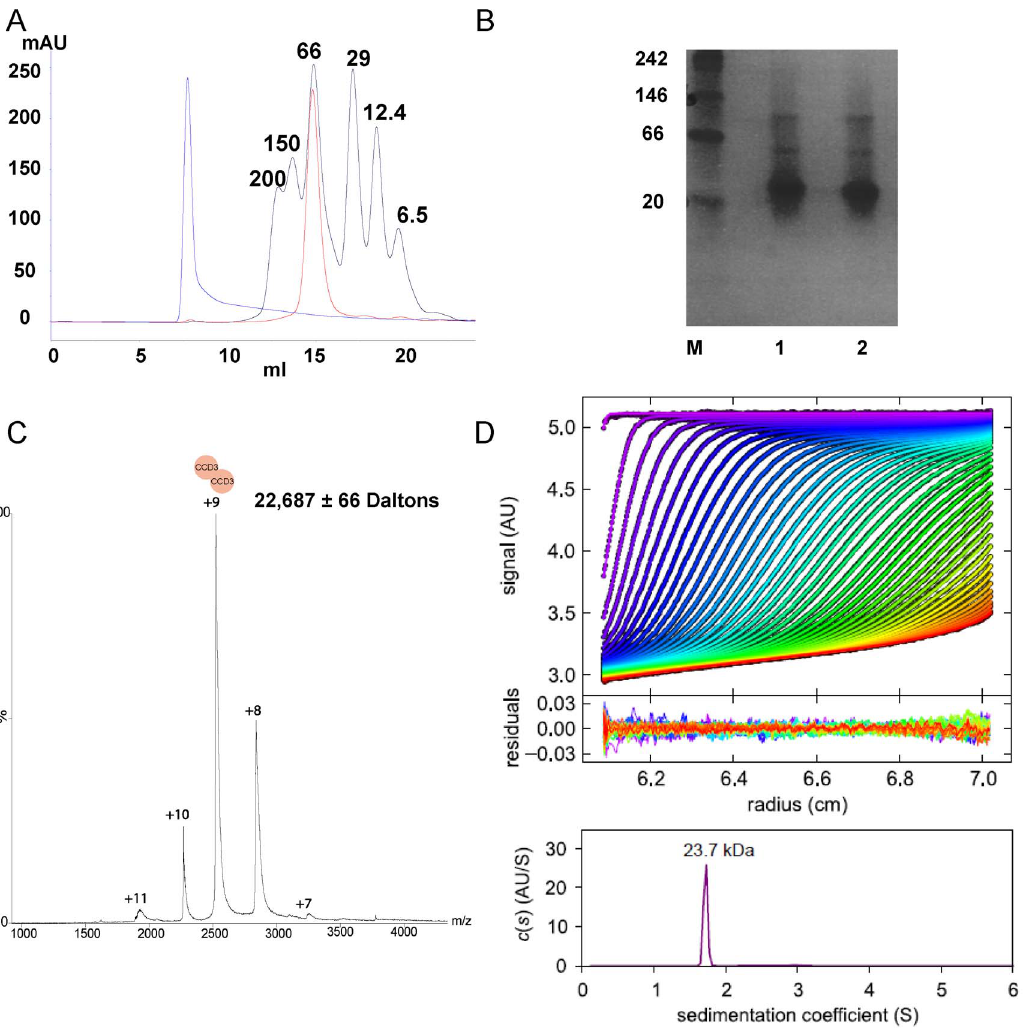
Figure 4. Characterisation of the oligomeric status of the human ATG16L1 coiled-coil domain. (A) Size exclusion chromatography of CCD3. CCD3 – red trace; Blue Dextran – blue trace; Molecular size markers – black trace (mass labelled in kDa). (B) Native-PAGE analysis of CCD3. 1 m g of CCD3 was analysed by Native-PAGE both before (lane 1) and after (lane 2) freeze/thawing at 2 80 u C. M – NativeMark TM protein standards (Life Tehnologies). (C) Nanospray Electrospray Ionisation Mass Spectroscopy (ESI-MS) analysis of CCD3 under conditions that preserve non-covalent interactions. CCD3 dimers are detected in the low m/z range corresponding to charge states of + 11 to + 7. There is no evidence of any additional species of CCD3. (D) Analytical ultracentrifugation sedimentation velocity data. Interference optical signal distributions of CCD3FH at time intervals of 320 s at a rotor speed of 50,000 rpm and a temperature of 20 u C, with systematic noise subtracted. The residuals are from the fit with the hybrid discrete/continuous model. Component sedimentation coefficient distributions showed a dominant population of the dimeric species, with a uniform frictional ratio of Fk,w=1.73. The final r.m.s.d. was 0.006.